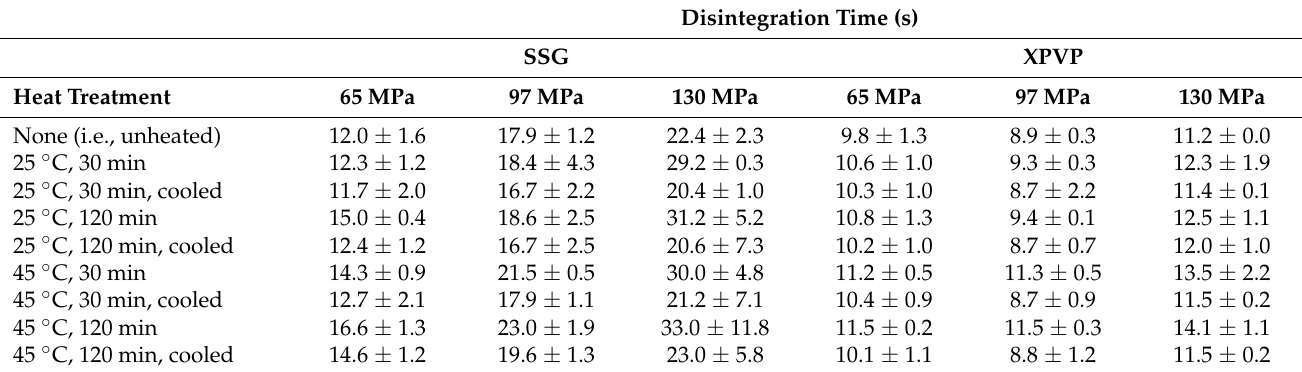
Table 3. Disintegration time of tablets containing SSG or XPVP, produced at different compaction pressures and subjected to different heat treatments.